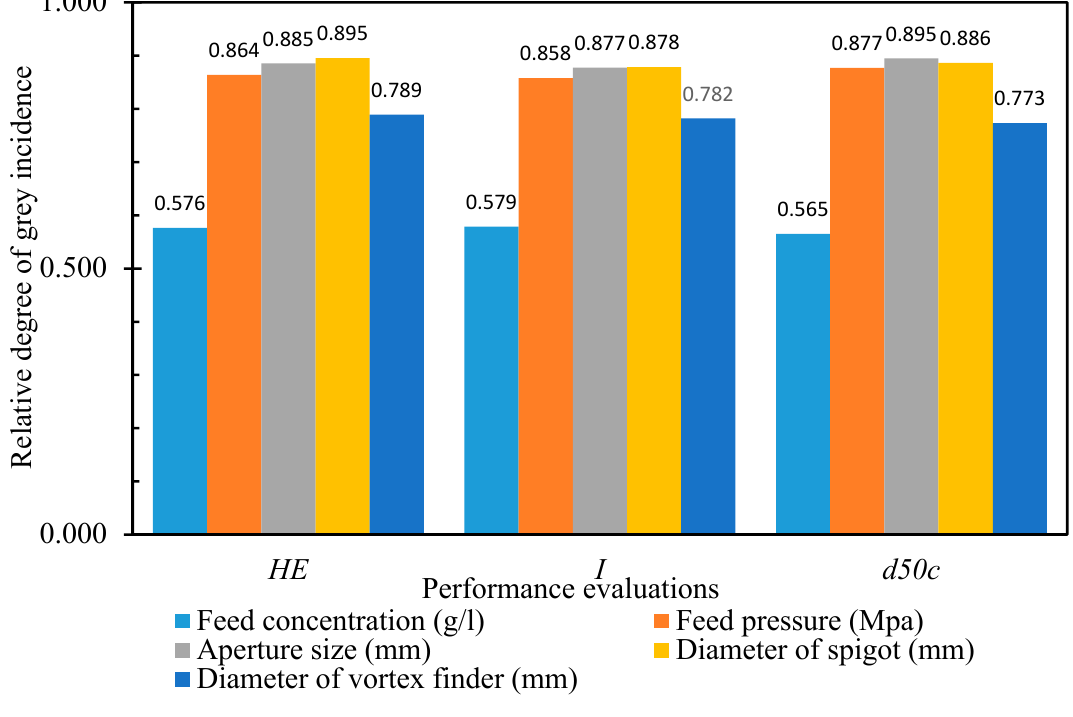
Figure 5. Relative degree of grey incidence for the performance in TPHS.